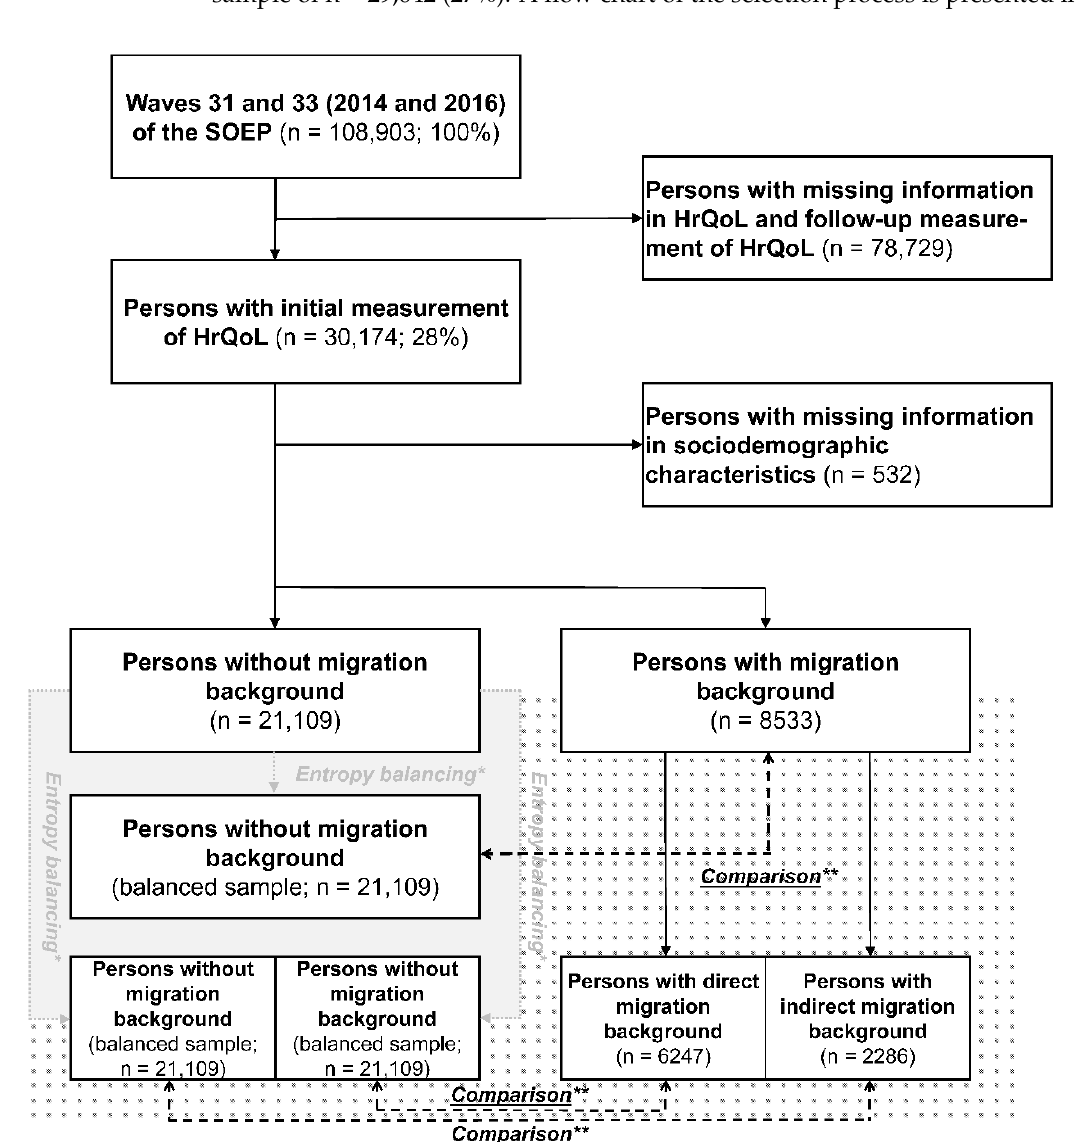
Figure 1. Flow chart of the selection and reweighting process. SOEP: German Socio-Economic Panel, HrQoL: health- related quality of life; * For the sample of persons without migration background, three different weights were derived using entropy balancing, thus differences in means and standard errors of sociodemographic characteristics between persons with and without migration background, persons with direct and without migration background, and persons with indirect and without migration background were equal by employment of the entropy balancing weights in the explanatory models. ** Differences in HrQoL with respect to migration background, direct migration background, and indirect migration background were evaluated by comparison with the respectively reweighted sample of persons without migration background.